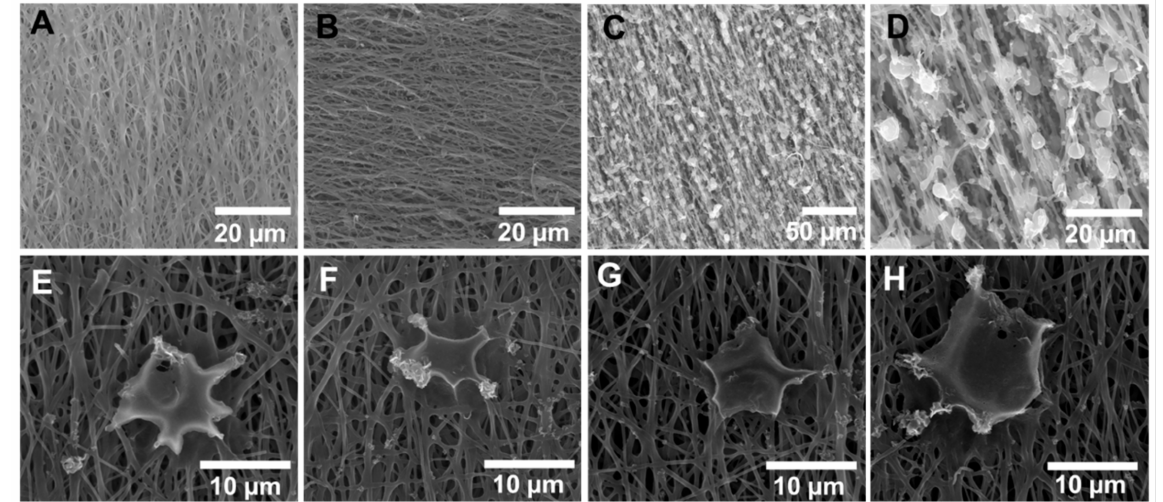
Figure 4. SEM imaging of electrospun fibers and PC12 cell morphology on the fibers. ( A ) NAC-loaded intraluminal fibers, ( B ) NAC-free intraluminal fibers, ( C , D ) pure electrospun PHBV fibers, ( E , F ) PC12 cell on NAC-loaded fibers, ( G , H ) PC12 cell on NAC-free